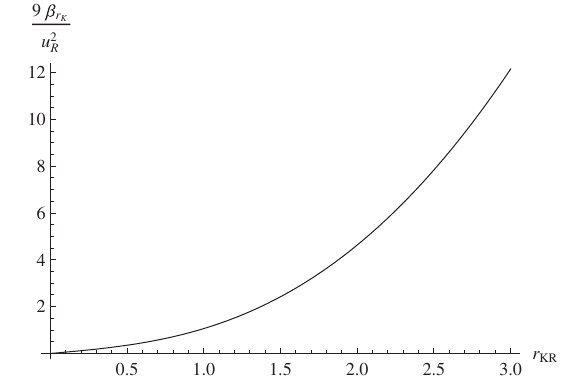
=u 2 R as a function of K